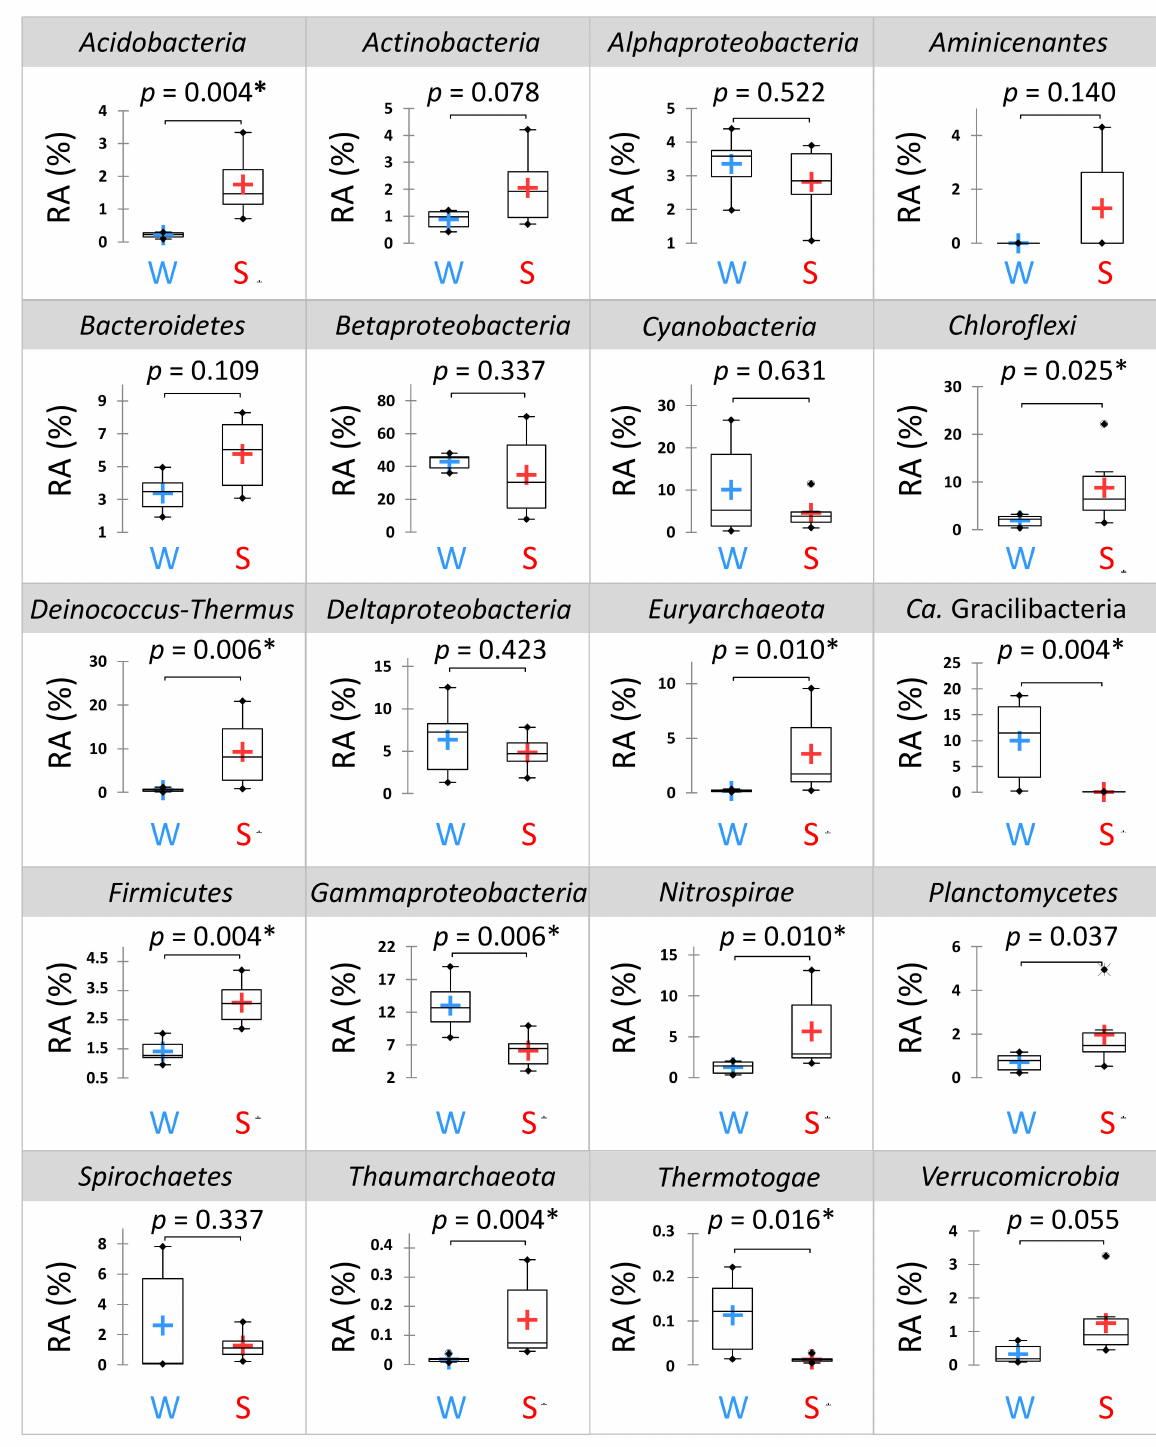
Figure 3. Boxplots showing variation of the relative abundance (RA; means ± standard deviations, n = 6) of the dominant phyla and proteobacterial classes (>1% in average) in the waters (W) and the sediments (S) of La Crouen Spring (New Caledonia). p values are obtained by Kruskal–Wallis test. p values < 0.05 indicate statistically significant differences between the two groups (W and S) and are indicated by